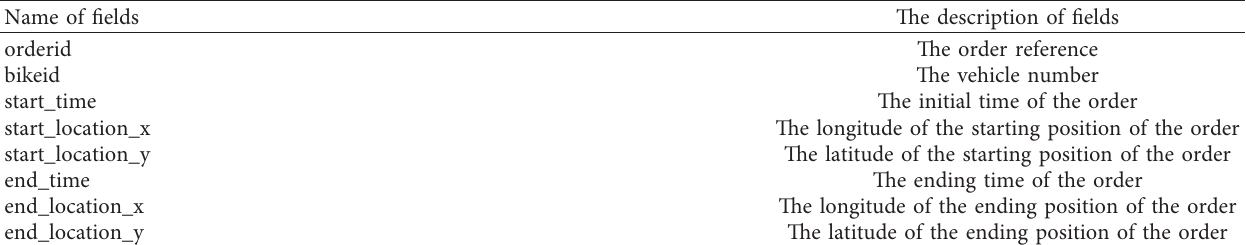
Table 1: The description of bike-sharing data.